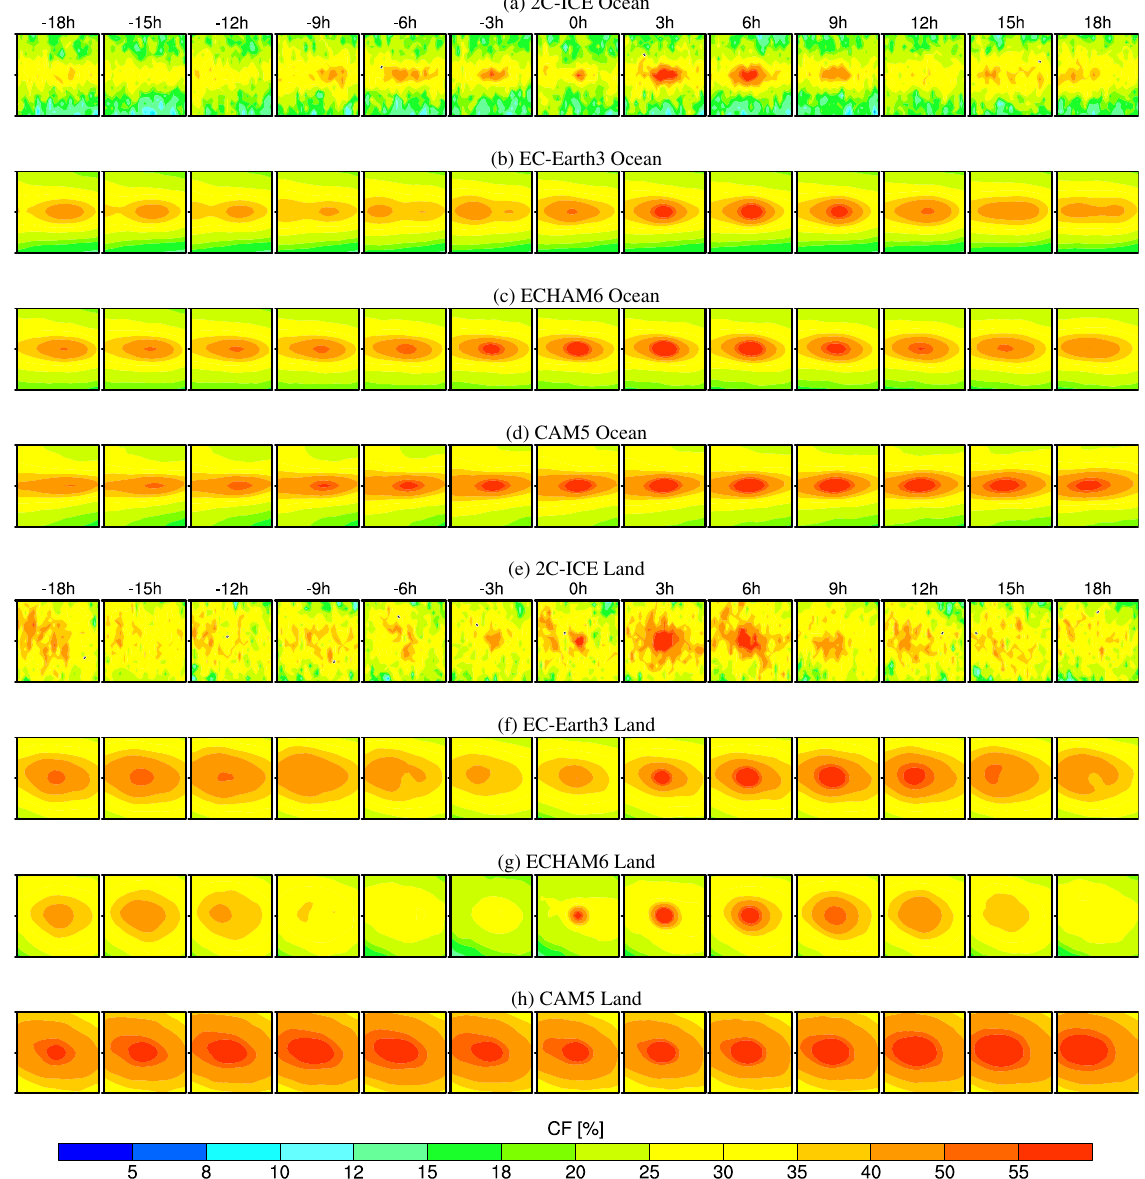
Figure 6. Composite of cloud fraction (CF) at 200hPa for ocean-based (a–d) and land-based (e–h) systems for 2C-ICE followed by the Fig. 6. Composite of cloud fraction (CF) for ocean-based ((a)-(d)) and land-based ((e)-(h)) systems for 2C-ICE followed by the models. The spatio-temporal coverage of ± 18 hours at every 3-hour interval and ± 10 ◦ longitude and latitude taken from the centre point and graduated models. The spatio-temporal coverage of ± 18h at every 3h interval and ± 10 ◦ longitude and latitude is taken from the centre point and every ± 1 ◦ . graduated every ± 1 ◦